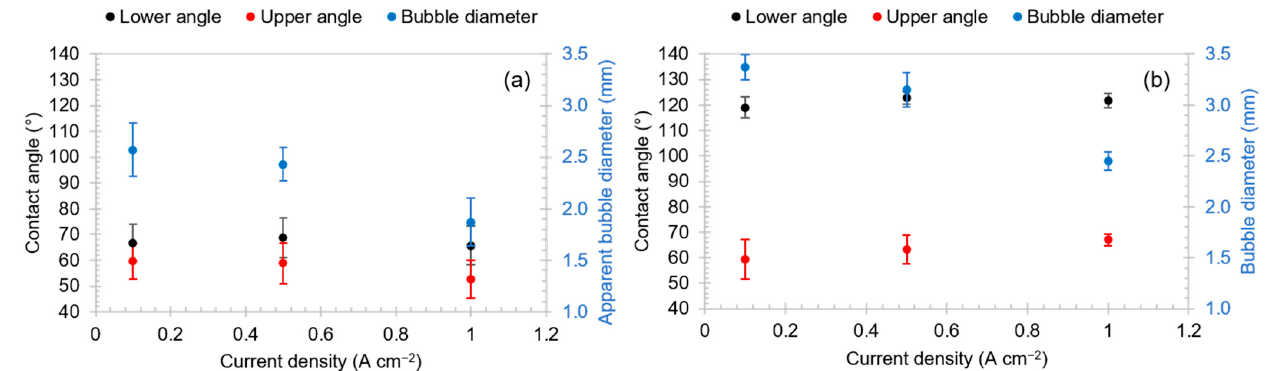
Figure 19. Lower and upper contact angle and the bubble diameter as a function of applied current density for the vertical anode, ( a ) for the bubble resting at the surface in the growth stage just before coalescence ( b ) for the bubble after coalescence just before detachment.